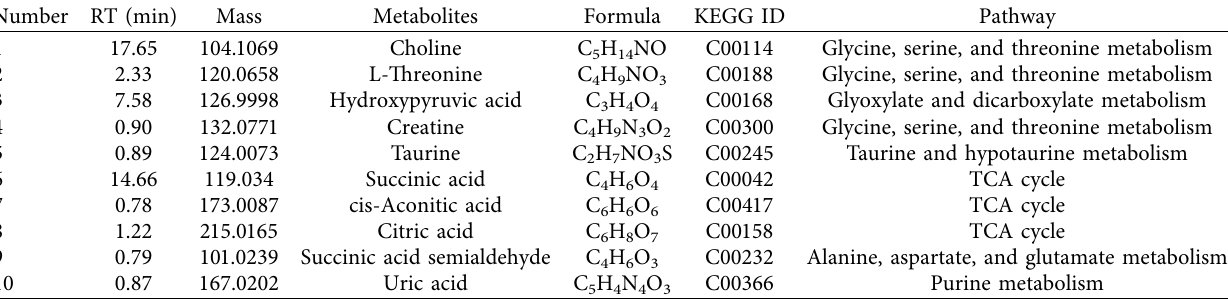
Table 2: Identification of serum and urinary metabolites in different